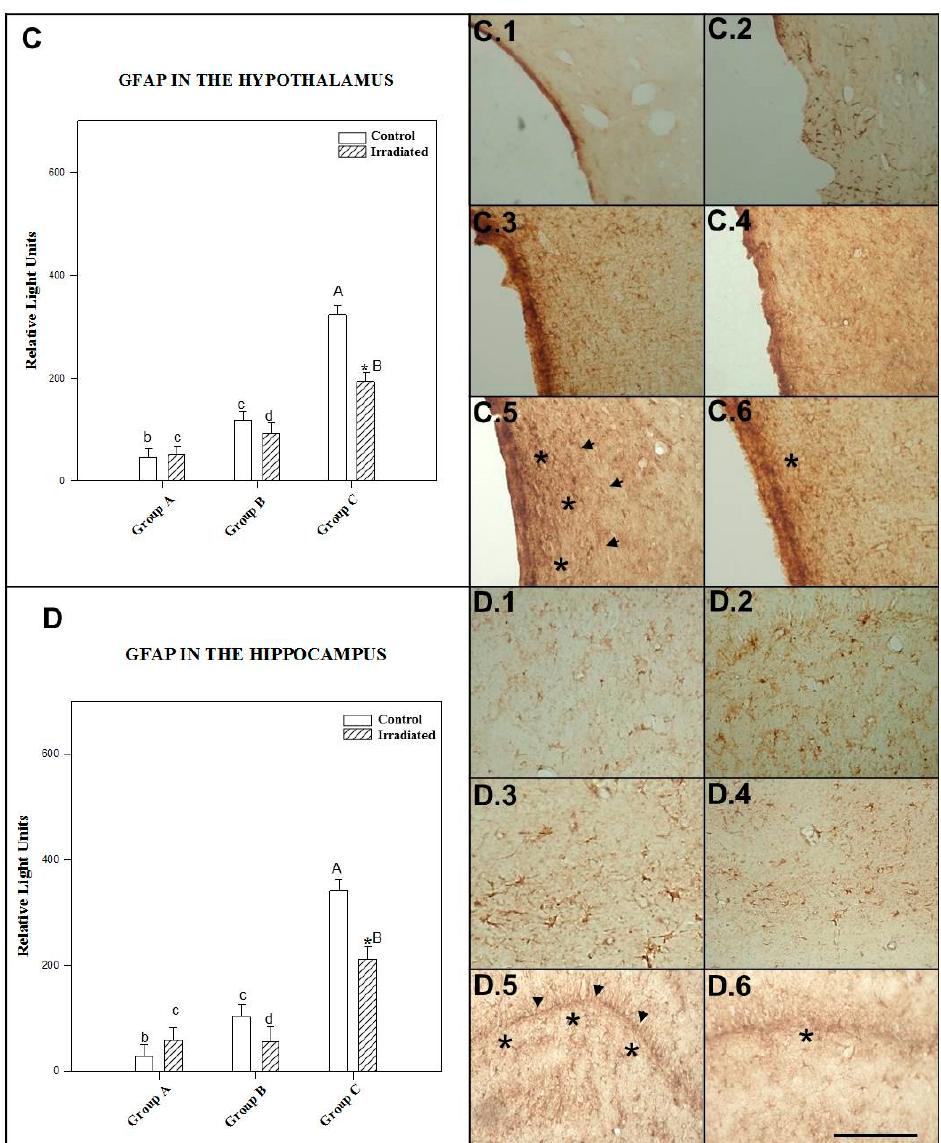
Figure 6. Glial fibrillary acidic protein (GFAP) levels detected by ELISA in the hypothalamus ( C ) and the hippocampus ( D ) 1.5 h (Group A) and 24 h (Group B) after acute exposure and 1.5 h after final repeated exposure (Group C) to a 2.45 GHz signal at 0 and 3 W. Each bar represents mean ± SEM ( n = 24 samples/per group). Asterisks (*) indicate statistically significant differences ( p < 0.05) between the irradiated and control for each group. a, b, c, d indicate statistically significant differences ( p < 0.05) between irradiated or nonirradiated animals comparing between the different groups A, B, C, which were determined using two-way ANOVA followed by the Holm-Sidak test for multiple comparisons. The photographs show the GFAP immunomarkers for groups A, B and C in hypothalamus, control (C.1, C.3 and C.5) and irradiated animals (C.2, C.4 and C.6); in hippocampus, control (D.1, D.3 and D.5) and irradiated animals (D.2, D.4 and D.6) ( n = 15 samples/per group). In the photos it is indicate with the arrowhead and asterisk that means increase on regional cytolocalization. Scale bar = 60 µ